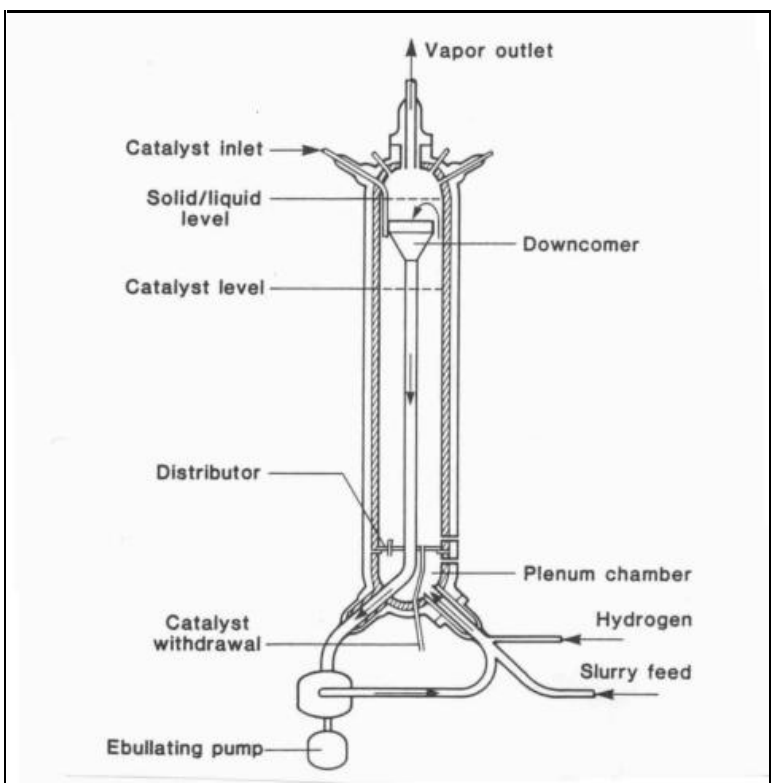
Figure 2. H-Coal